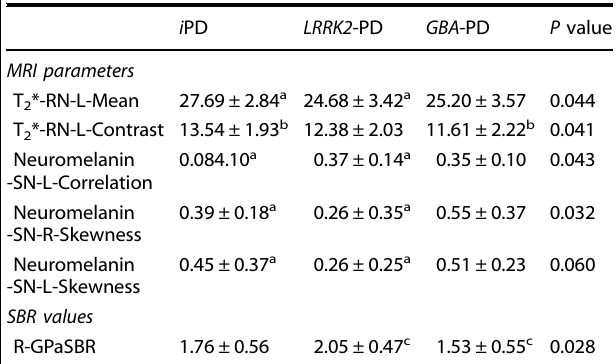
Table 4. Genotype-related changes in patients with